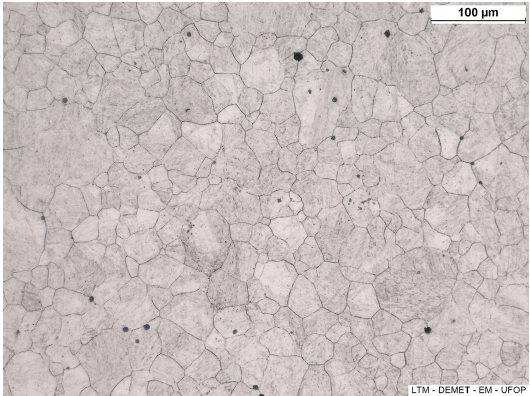
Figure 7. Prior austenitic grains for the austenitizing temperature of 1000°C. Etchant: Teepol. OM. 200x.